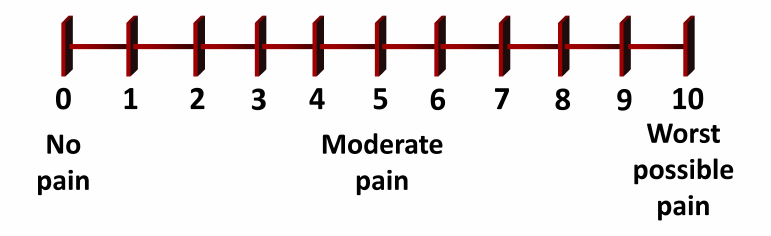
Figure 1. visual analog scale (VAS) pain